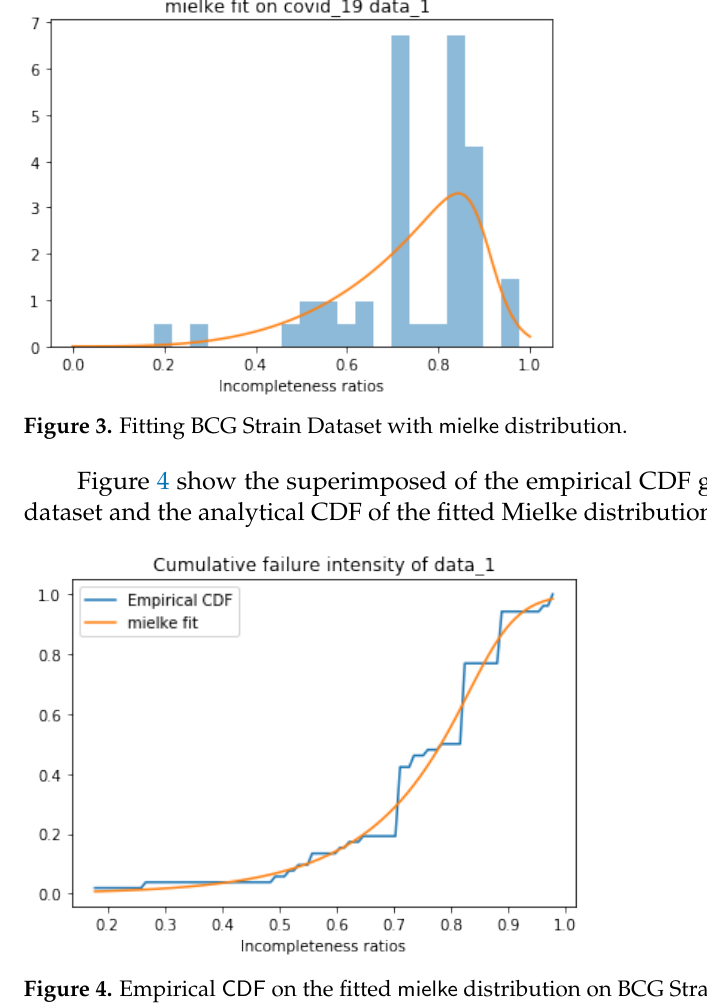
Figure 4. Empirical CDF on the fitted mielke distribution on BCG Strains